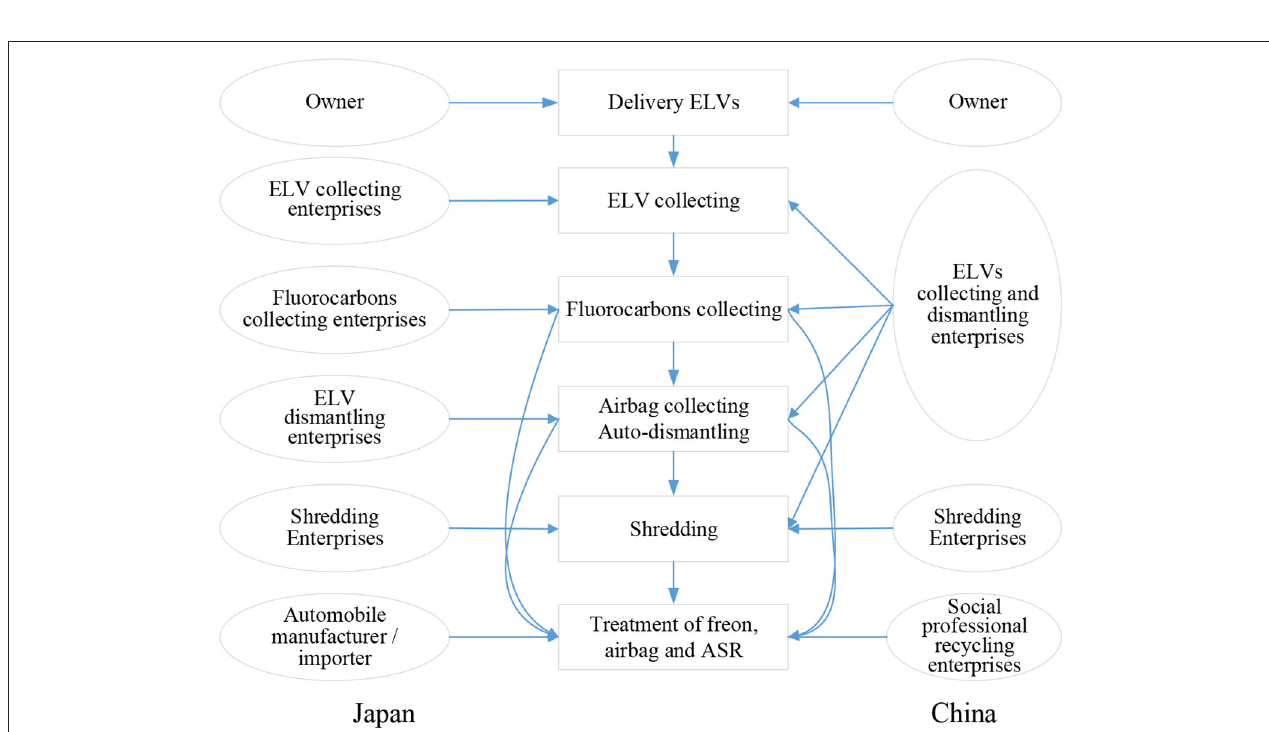
FIGURE 10 | Comparison of participating subjects and responsibilities of the ELV recycling system in China and Japan.